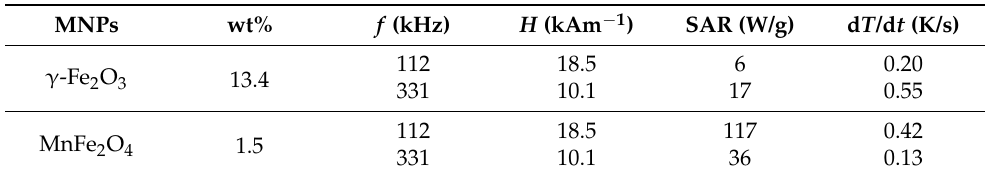
Table 2. MNPs material, wt% of MNPs in water, frequency ( f ), magnetic field amplitude ( H ), specific absorption rate (SAR), and dT/dt slope.